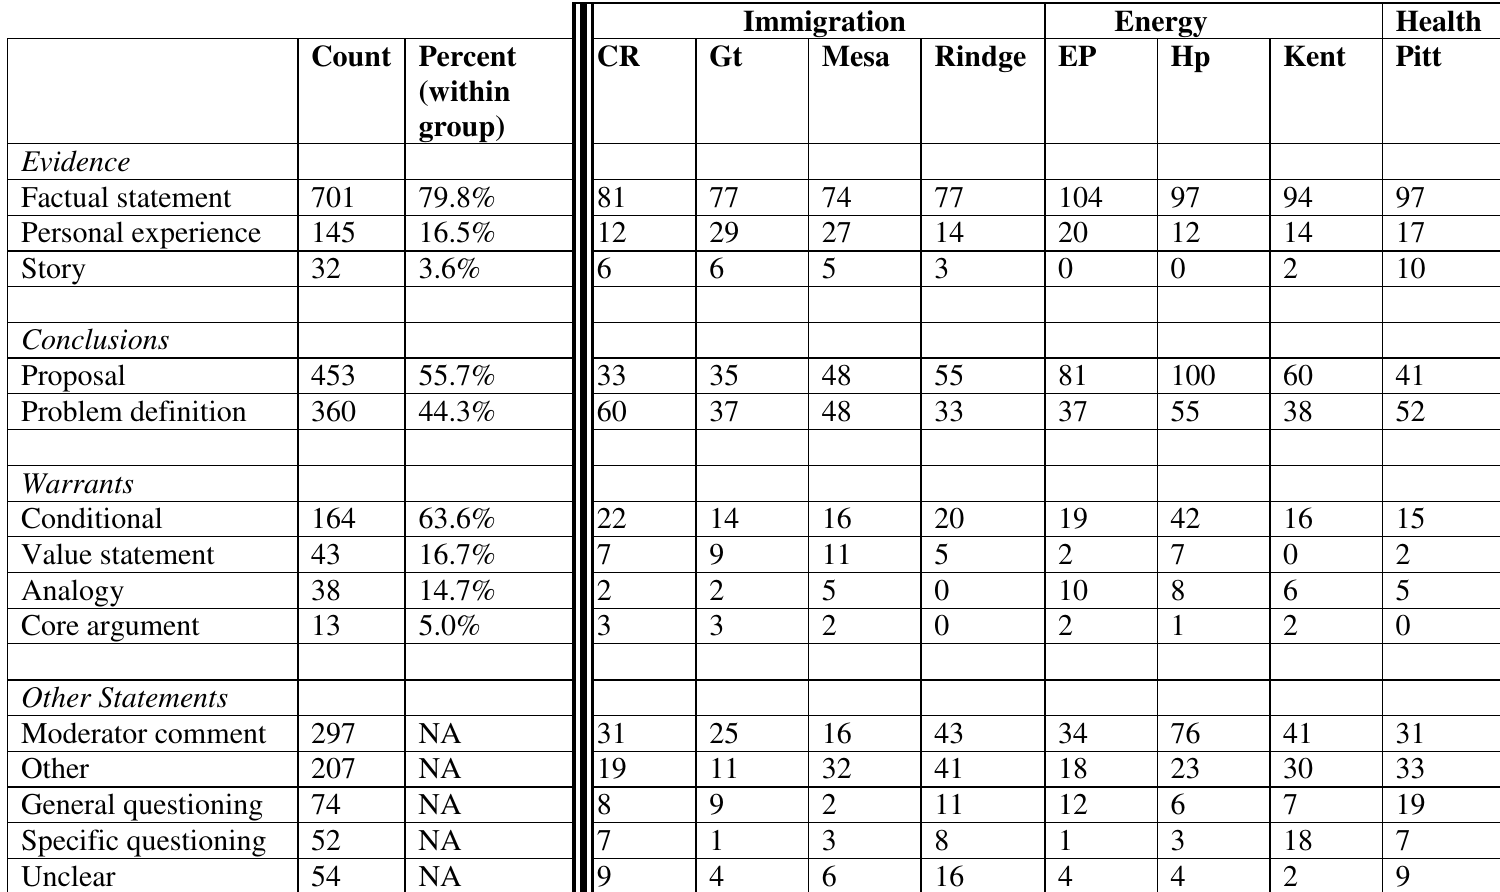
Table 2: Frequency of Evidence and Conclusions in Deliberator